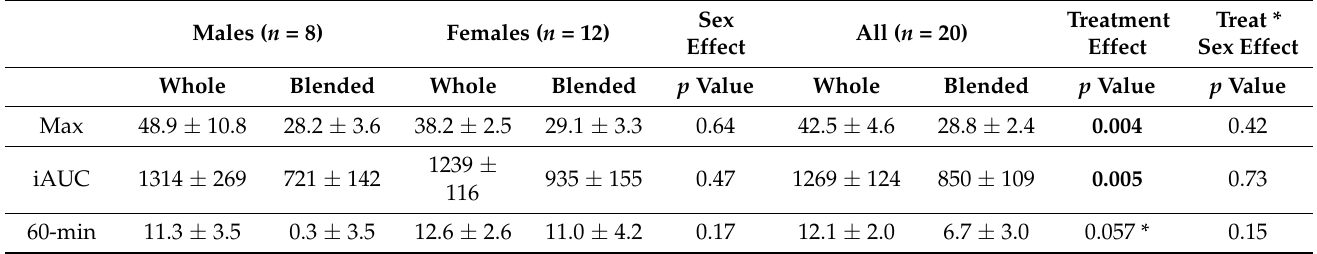
“Max” is maximum blood glucose (mg/dL), “iAUC” is incremental area under the curve for glucose (mg/dL × min), and “60-min” is the incremental blood glucose value at 60 min (mg/dL). The “ p value” columns provide p values from a repeated measures two-way ANOVA with treatment as the within-subjects variable and sex as the between-subjects factor. Statistically significant p values are bolded and marginally statistically significant p values have an asterisk.